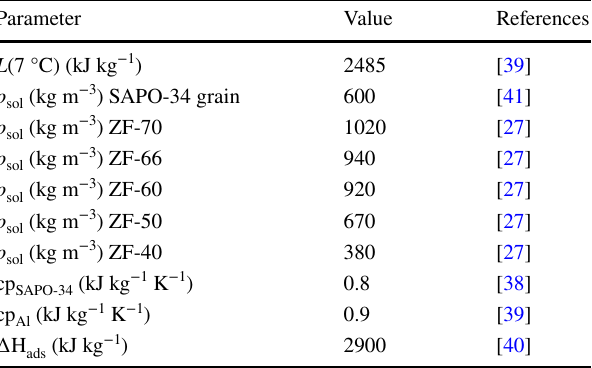
Table 3 Values of the parameters employed for the thermodynamic models Parameter